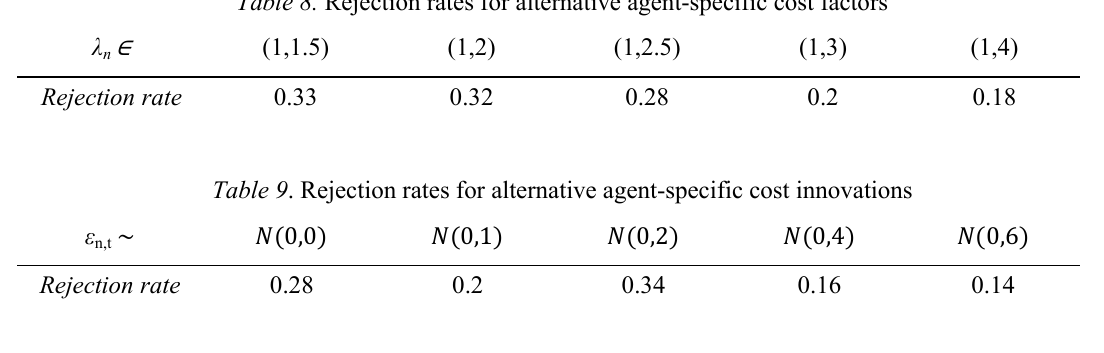
Table 10 . Rejection rates for alternative sensitivity to changes in the fitness function